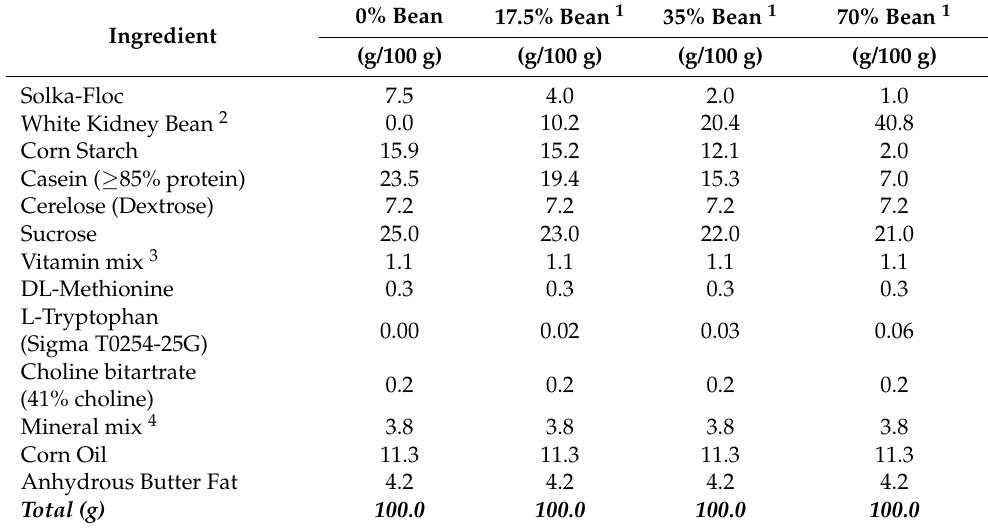
Table 1. Experimental diets